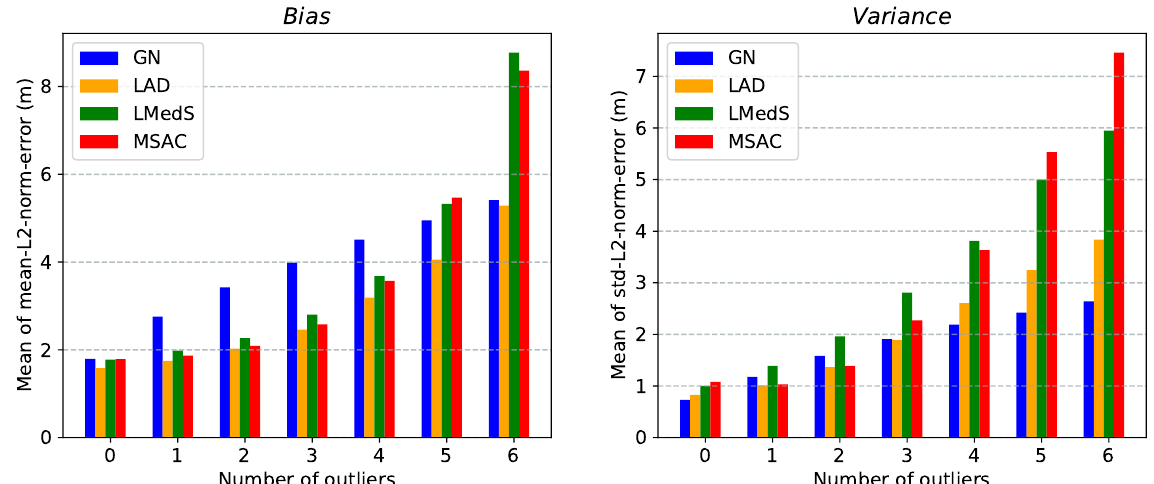
Figure 9. Simulation results for i.i.d. Exponential noise in the ToA measurements with distance-dependent scale. The first column shows the bias , and the second column shows variance . The noise in ToA measurements are from an i.i.d. Exponential distribution with scale σ = d /3000 ms, where d is the actual distance (m) between a transmitter and a receiver. The outliers are created by adding random values from an i.i.d. Uniform distribution in the interval [ − 15, − 5 ] (cid:83) [ 5,15 ] ms to some of the ToA